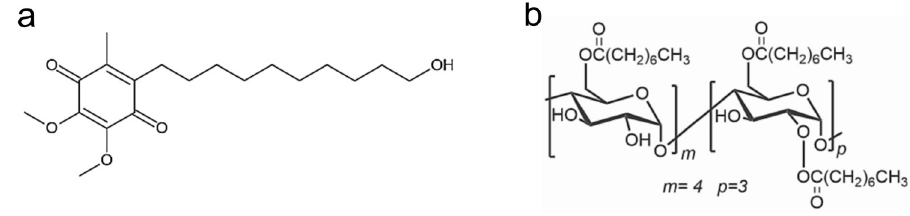
Figure 1. Chemical structure of IDE ( a ) and ACyD8 ( b ).